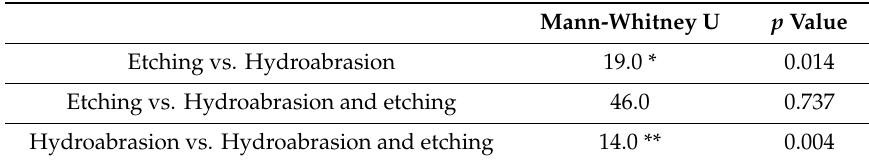
Table 4. Post hoc pairwise comparisons of adhesive remnant index (ARI) scores frequency between the groups ( n =